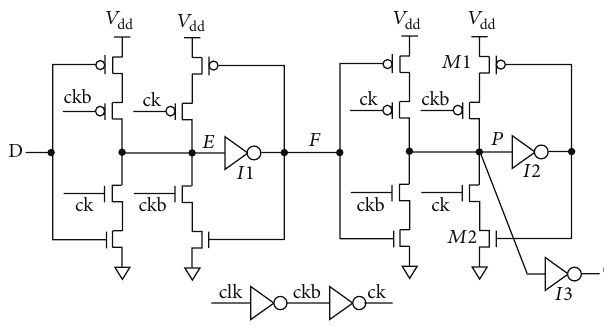
Figure 3: C 2 MOS master-slave flip-flop (C2FF).